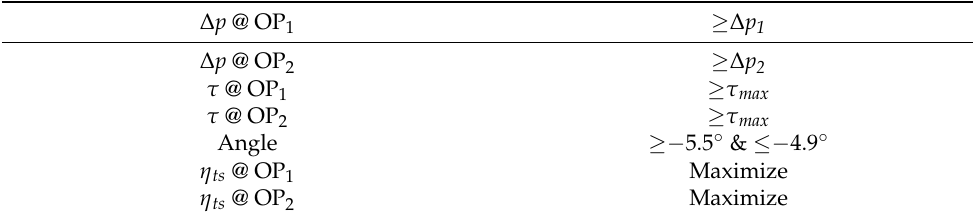
Table 3. Optimization constraints and objectives.